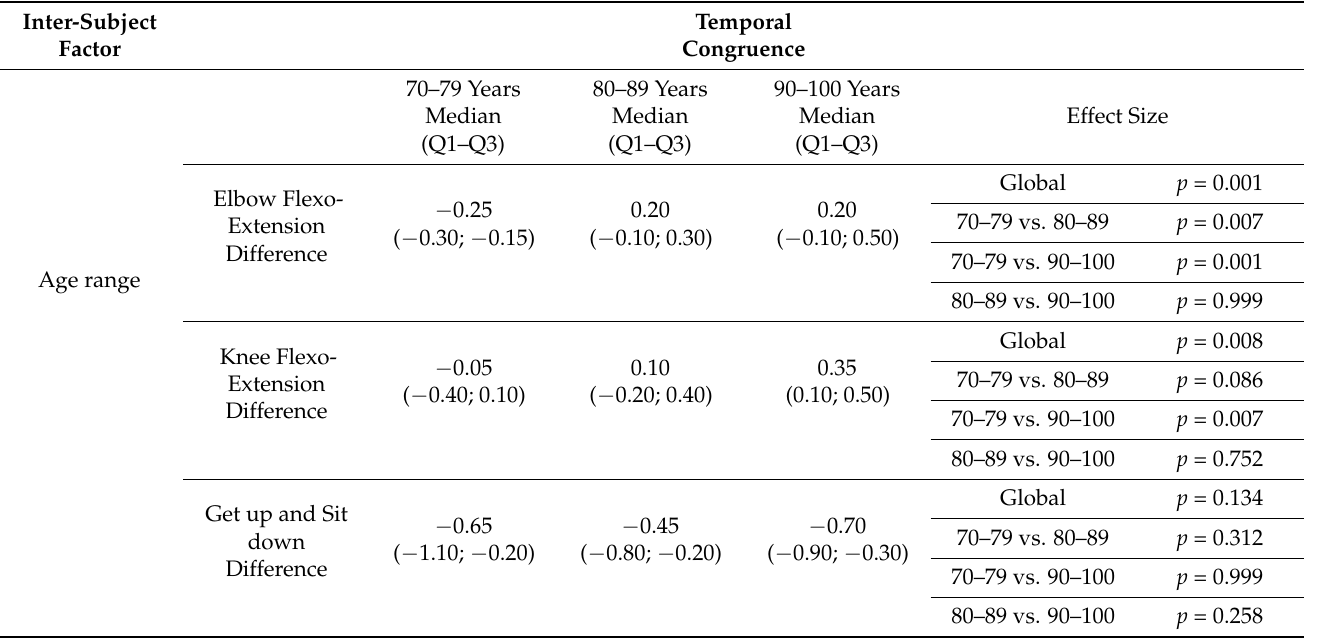
Table 7. Temporal congruence concerning